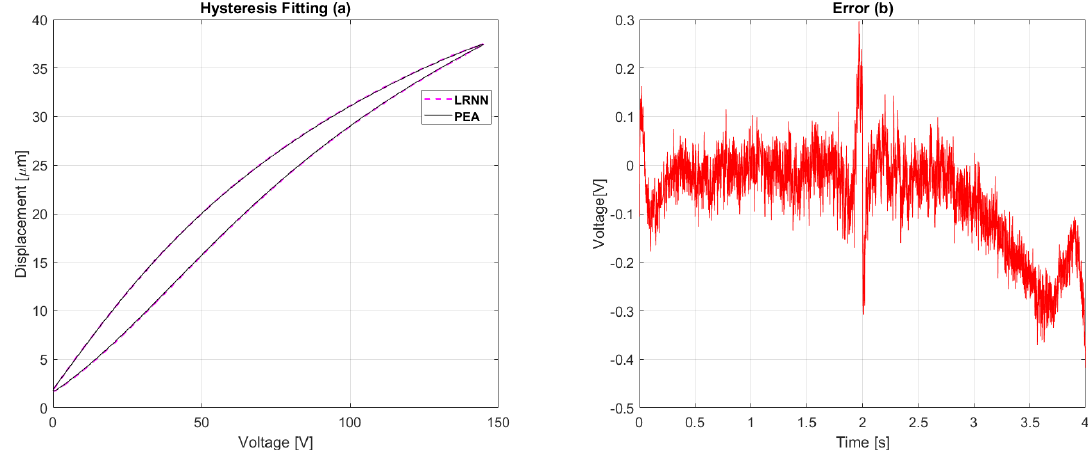
Figure 6. Performance of the Layer Recurrent Neural Network (LRNN), where: ( a ) hysteresis fitting; ( b ) error